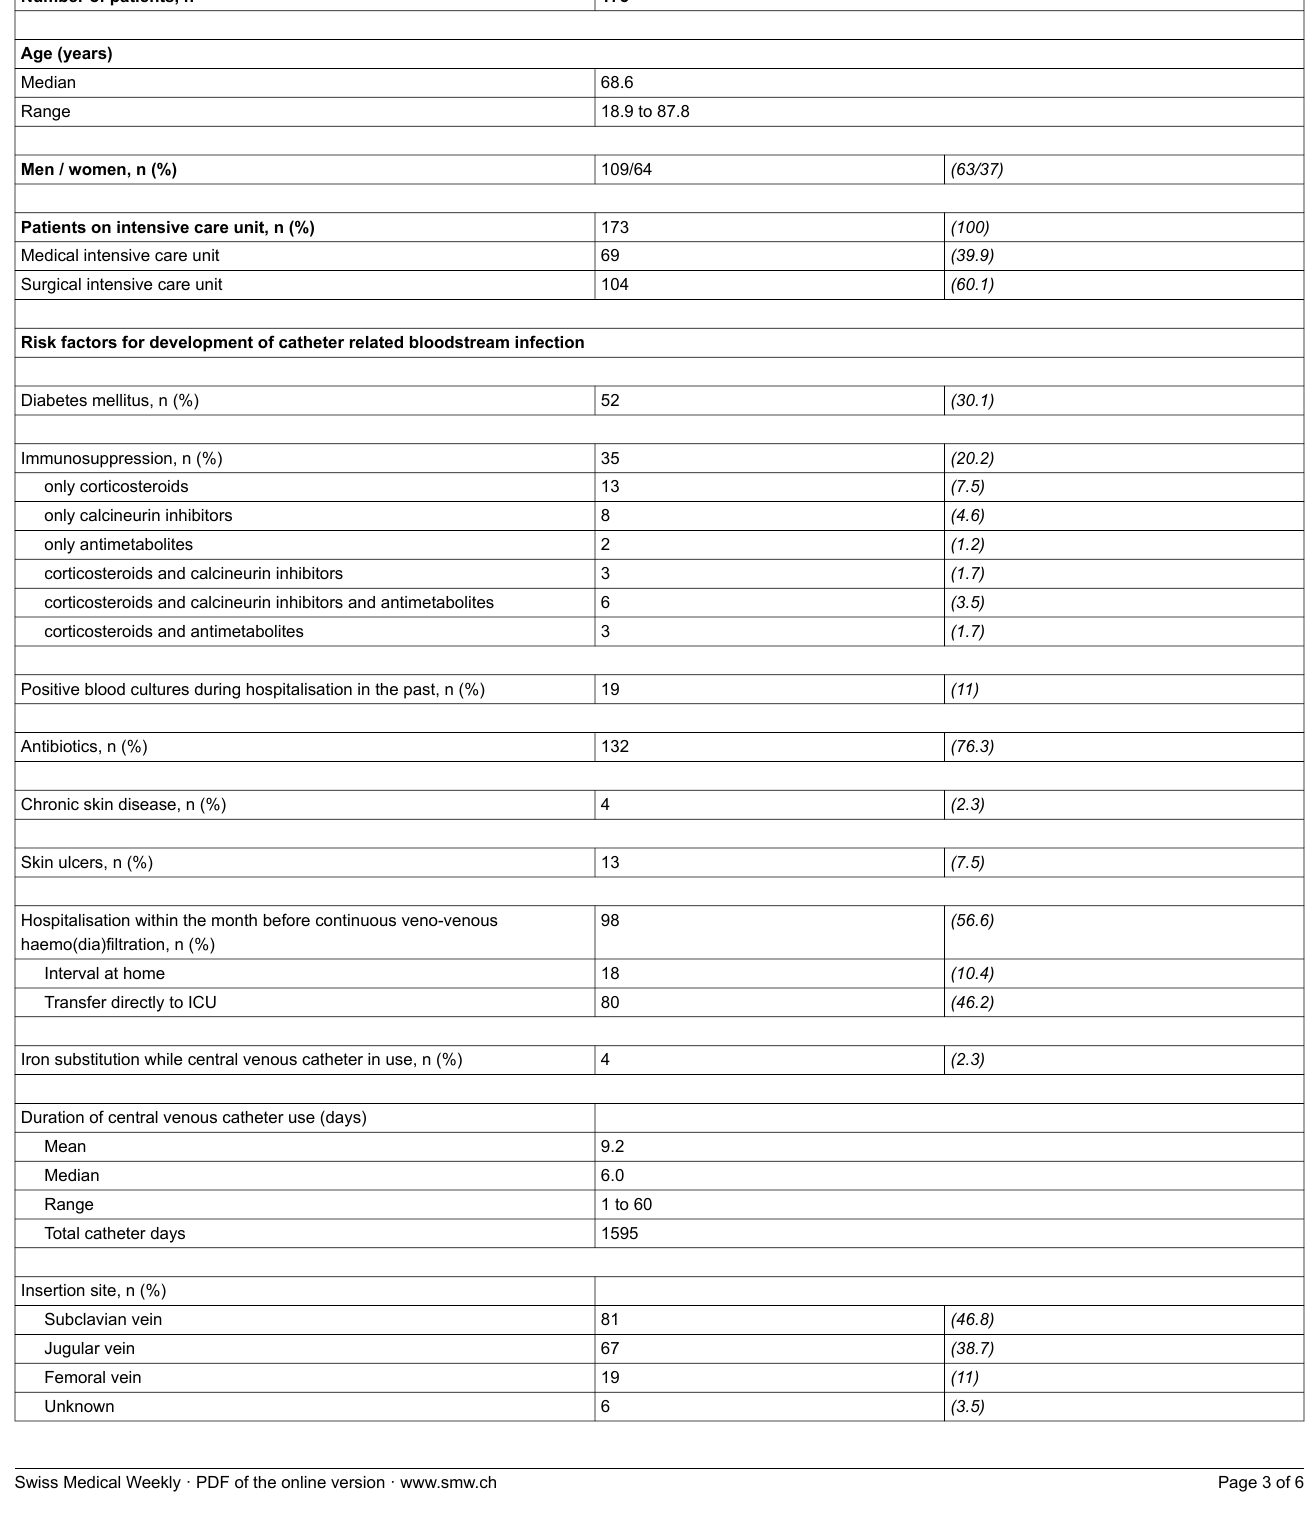
Table 1: Patient characteristics. Number of patients,